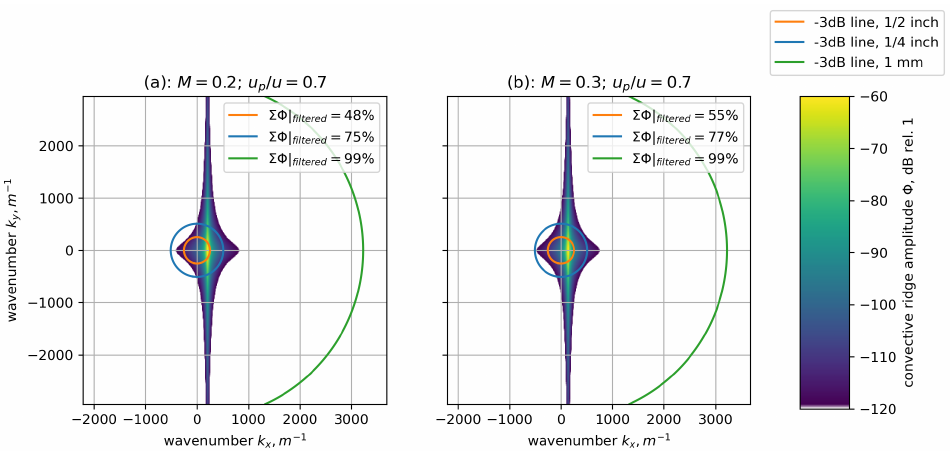
Figure 2. Exemplary attenuation caused by broadening of sources in the wavenumber domain due to limited coherence length. ( a ) M = 0.2 ( b ) M =